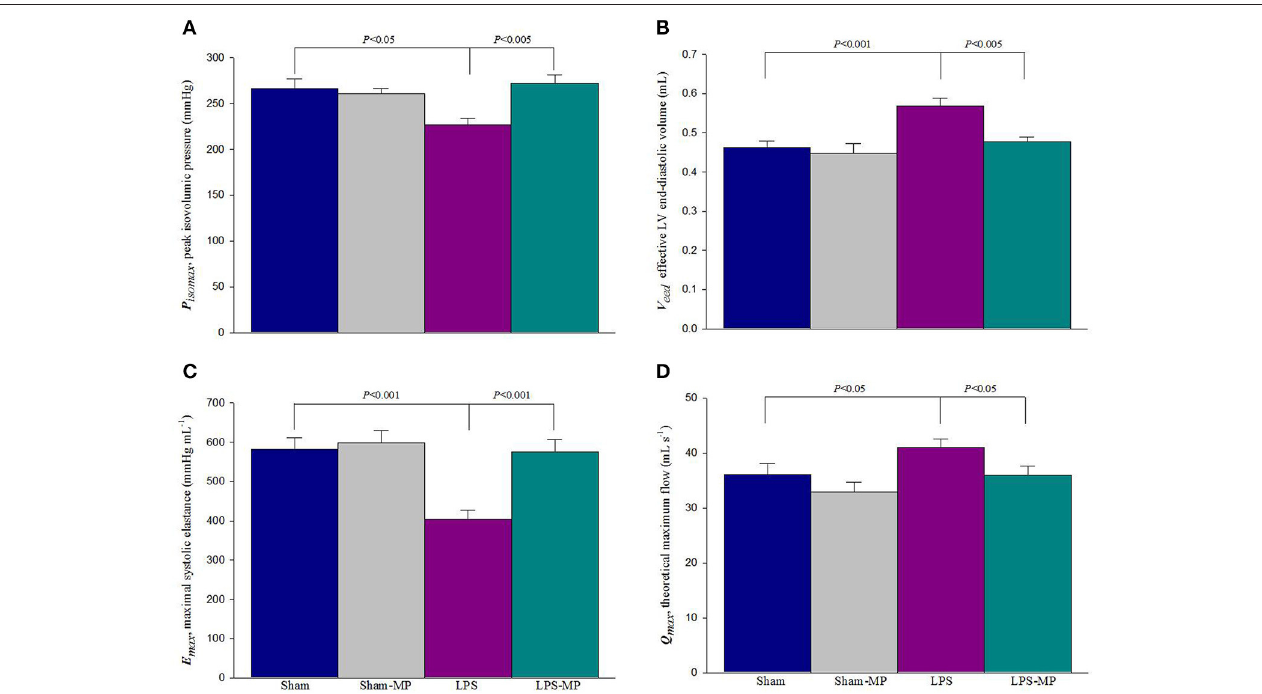
FIGURE 5 | Effects of LPS and MP on P iso max (A), V eed (B), E max (C), and Q max (D). The ratio of P iso max to V eed determines the LV E max . Results are expressed as the mean ± s.e. LPS, lipopolysaccharide; LV, left ventricular; MP, methylprednisolone; P iso max , estimated peak isovolumic pressure; V eed , effective LV end-diastolic volume; E max , maximal systolic elastance; Q max , theoretical maximum flow ( n = 10 /group).